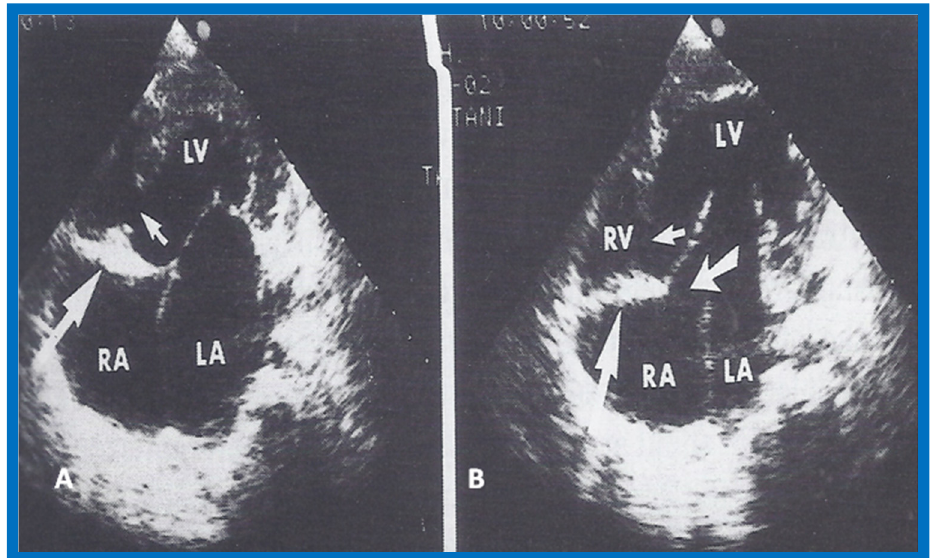
Figure 16. Apical four-chamber view pictures of another infant with tricuspid atresia (large arrows in A , B ) with ostium primum atrial septal defect (slanted arrow in B ). Note small right ventricle (RV) and a ventricular septal defect (small arrows in A and B ). LA, left atrium; LV, left ventricle; RA, right atrium. Reproduced from Covitz W., Rao P.S. [36].